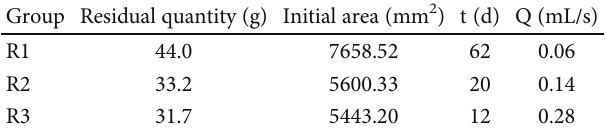
Table 2: Experimental design.